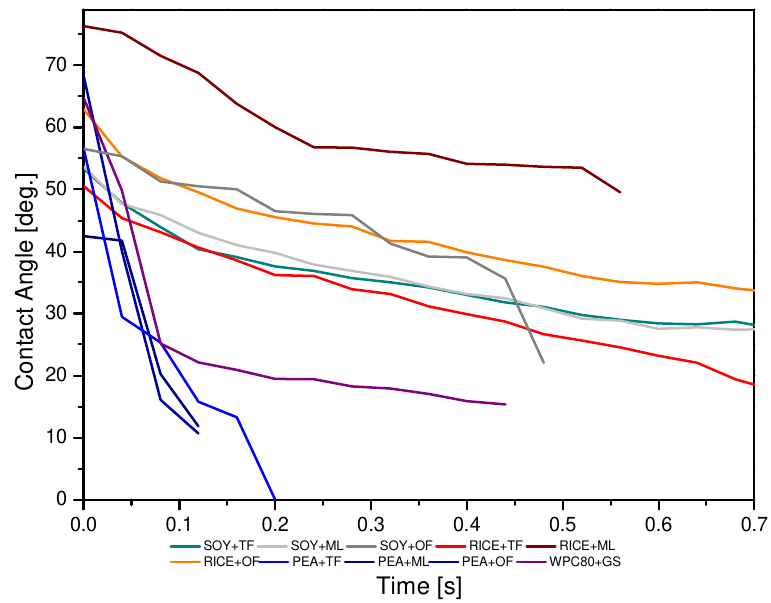
Figure 5. Comparison of individual water droplets kinetics depending on the type of protein and syrup used in the production of the developed high-protein bars.